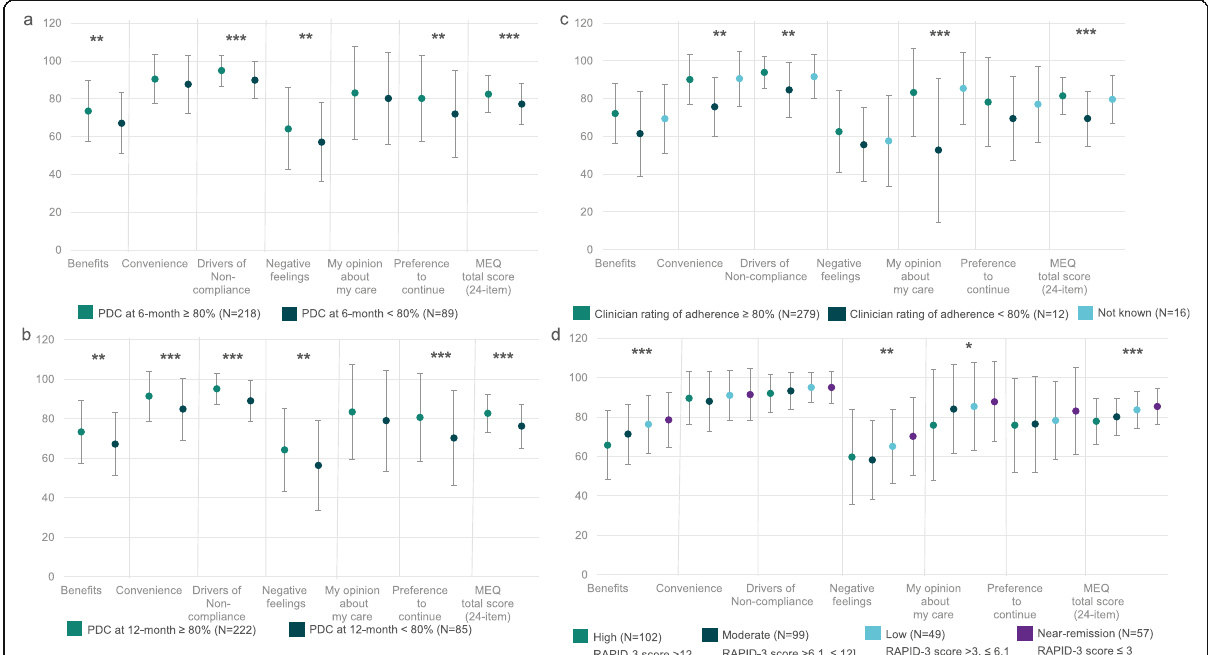
Fig. 2 Known-groups validity - Mean (standard deviation) MEQ dimension and Total Scores by a) 6-month PDC, b) 12-month PDC, c) clinician rating of adherence and d) disease severity according to RAPID-3 scores. p -value from T-test for between-group comparisons when two groups, from ANOVA when more than two groups, * p ≤ 0.05, ** p ≤ 0.01, *** p ≤